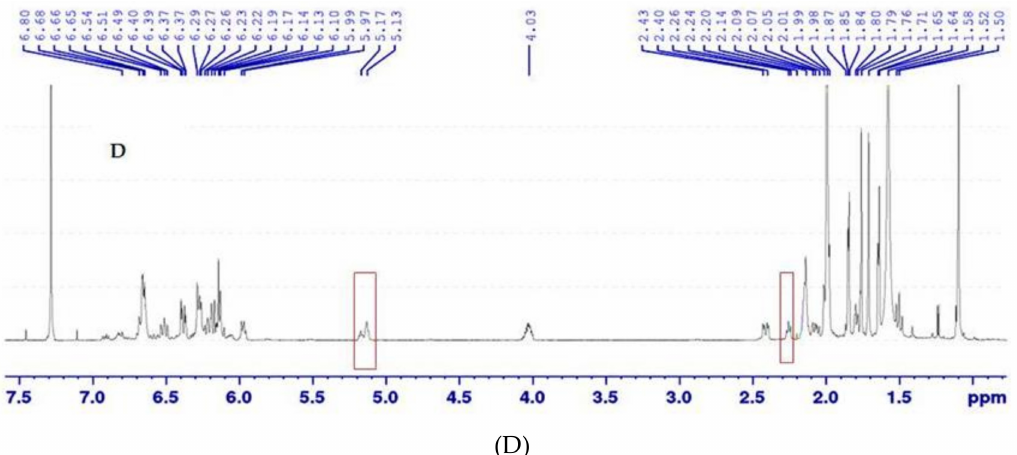
Figure 3. ( A ) Chromatographic separation of (all-E)- rubixanthin and ( 5 (cid:48) Z)- rubixanthin, using a C30 reversed phase column (see text for chromatographic conditions). ( B ) Structures of (all-E)- rubixanthin and (5 (cid:48) Z)- rubixanthin. ( C ) 1 H nuclear magnetic resonance (NMR) spectrum (600 MHz, 293 K, CDCl 3 ) of (all-E)- rubixanthin prior to light exposition. ( D ) 1 H NMR spectrum (600 MHz, 293 K, CDCl 3 ) of (5 (cid:48) Z )-rubixanthin after light exposition.